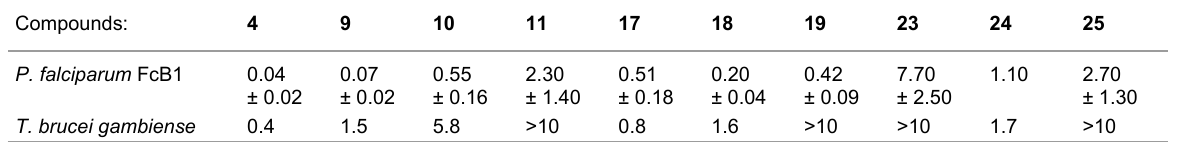
Table 3: Antiparasitic activities on Plasmodium falciparum FcB1 and Trypanosoma brucei gambiense (IC 50 , µg/mL). a